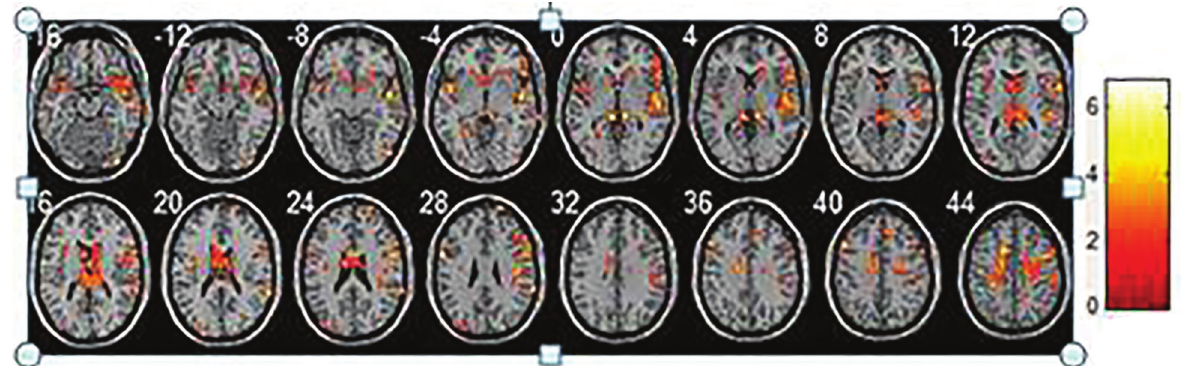
Figure 4. Regions where homogeneity increased in the amnestic mild cognitive impairment groups compared with the normal elderlies. Each image represents a slice, with 4 mm distance from the other. 0 is the 0 position of space coordinates. The color bar indicates energy Table 2. Regions of the brain with increased regional homogeneity in the amnestic mild cognitive impairment (aMCI) group compared with the normal group (P=0.008). Brain region